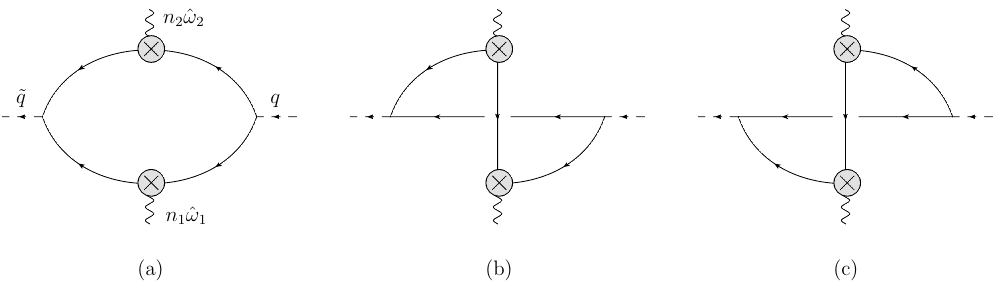
(ˆ ω ) O (ˆ ω ) i in the Born approximation. 1 , n 1 J 2 2 , n 2 q 1